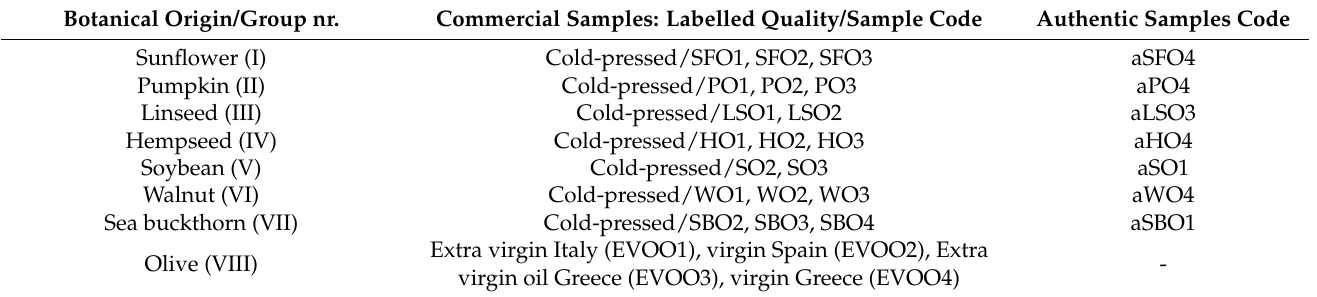
Table 1. The botanical origin, the labelled quality, and codes used in all investigations and statistical classifications of commercial and authentic